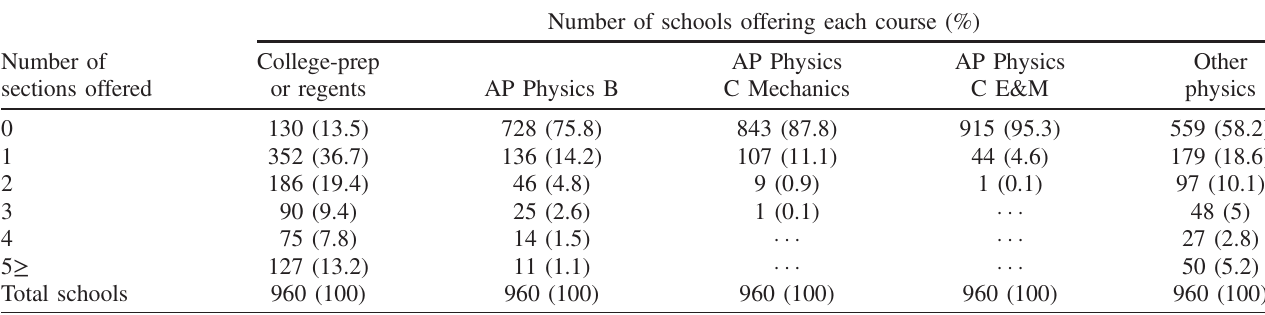
TABLE IV. Prevalence of physics courses in schools that offered physics. Number of schools offering each course